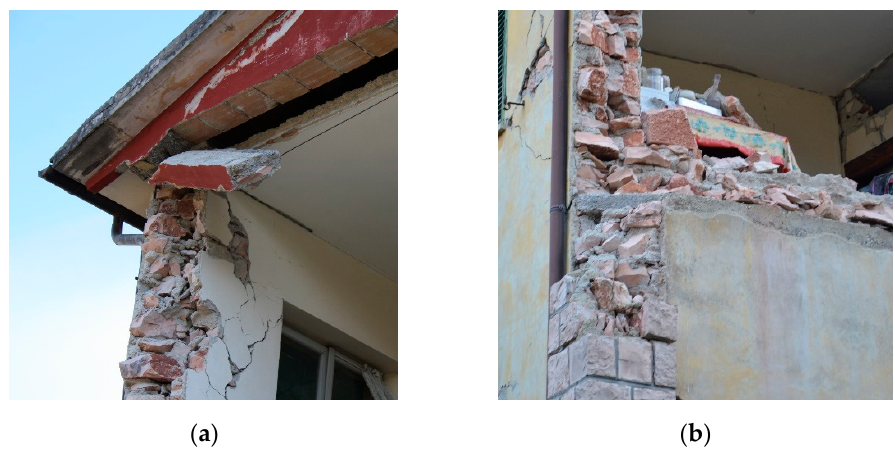
Figure 6. Details of unreinforced ring beams at ( a ) ceiling and ( b ) floor levels.